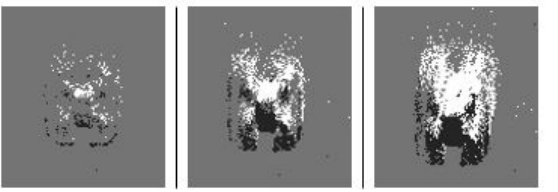
Figure 3. Various t a were assessed by training experimental networks before selecting a value for dataset capture. (Left to Right) t a = 0.05 s, t a = 0.1 s, and t a = 0.15 s. The t a that provided the values of precision and recall closest to 1 were used for all subsequent data and